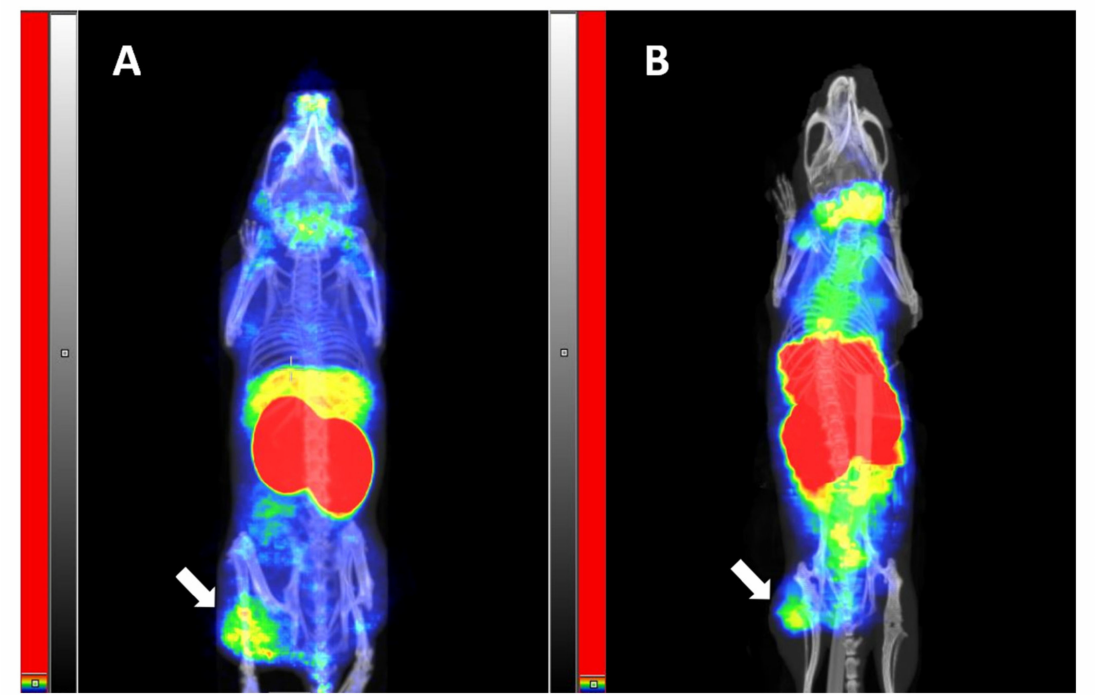
Figure 7. Imaging of IGF-1R expression in DU145 xenografts, using [ 68 Ga]Ga-NODAGA-(HE) 3 - Z IGF-1R:4551 ( A ) and [ 111 In]In-NODAGA-(HE) 3 -Z IGF-1R:4551 ( B ). The images were acquired 1 h after injection, using nanoScan PET/CT ( A ) and nanoScan SPECT/CT ( B ), and presented as maximum intensity projections. The arrows point at the